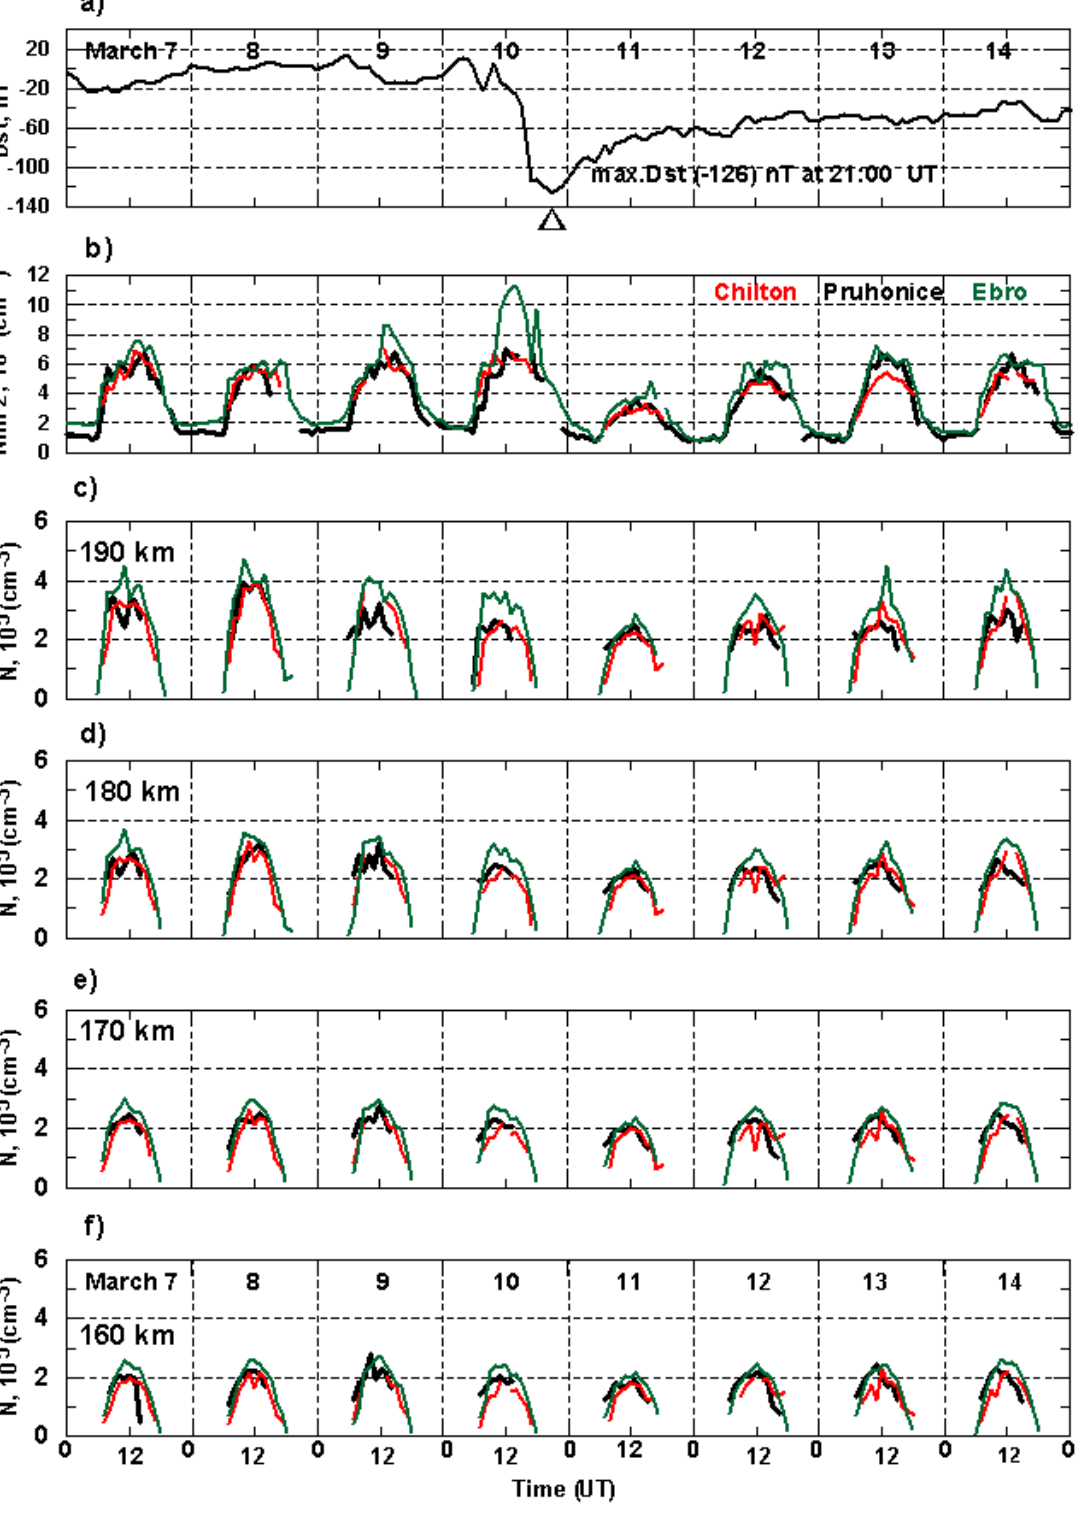
Fig. 6. Storm of March 1998: (a) hourly D st indices, (b) hourly values of Nm F2 for Chilton, Pruhonice and Ebro, (c–f) daytime electron density at 190, 180, 170 and 160km, respectively, for all stations. Time is in